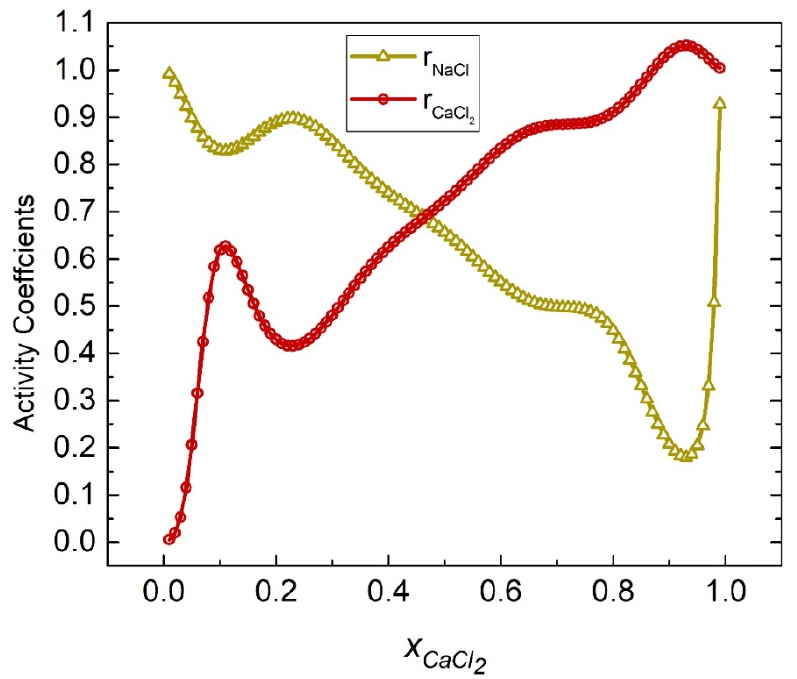
Figure 9. Calculated activity coefficients of each element of the NaCl-CaCl 2 system (998 K).